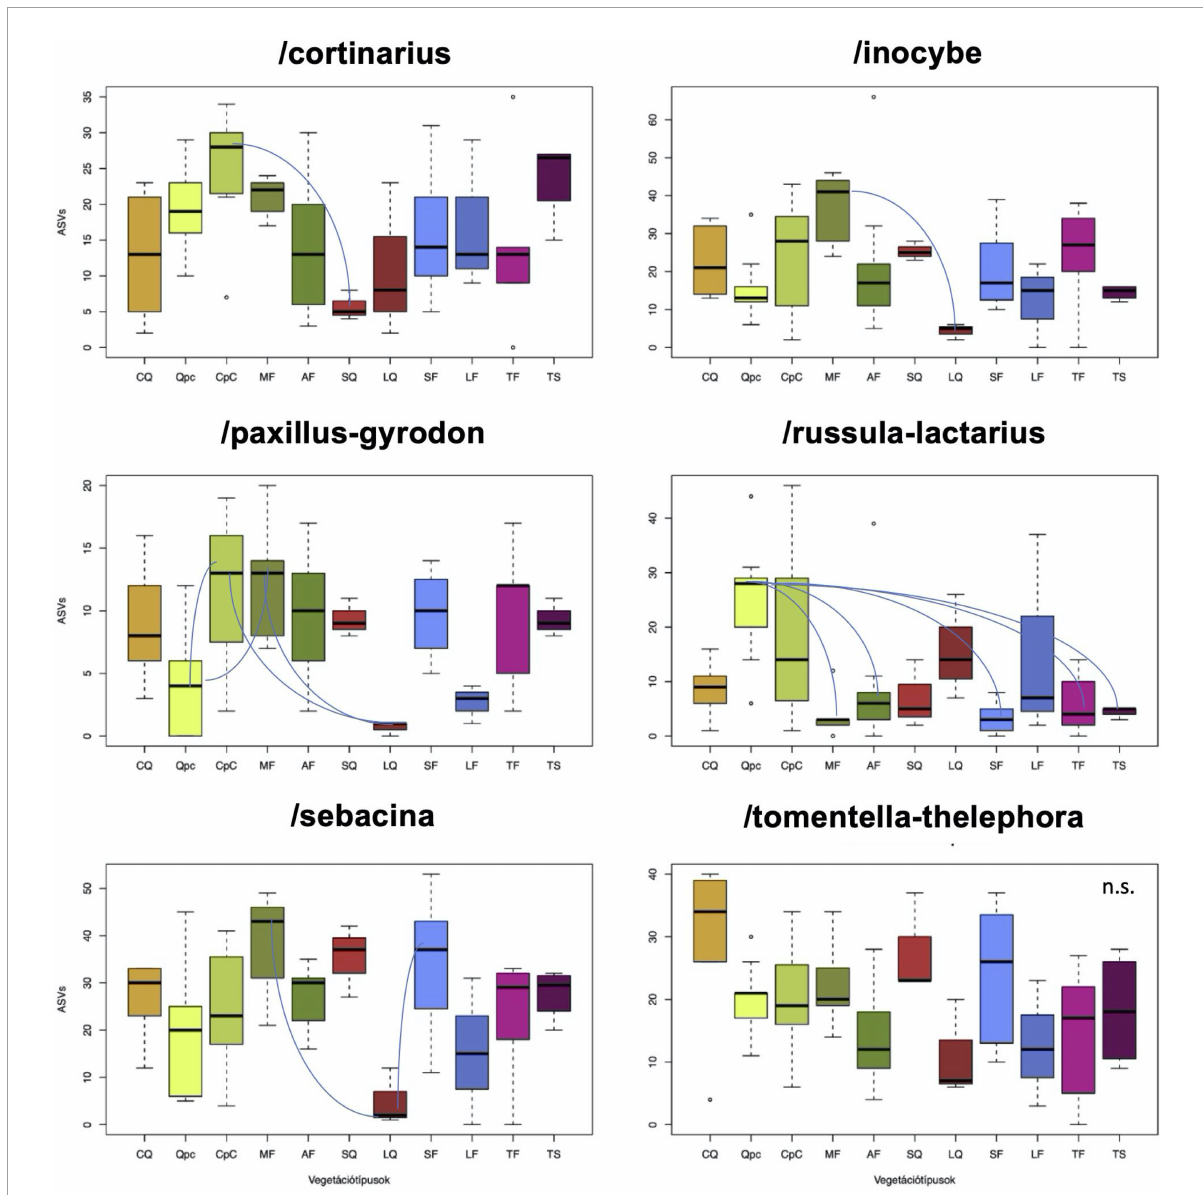
FIGURE2 Comparison of amplicon sequence variant (ASV) richness of the dominant ectomycorrhizal (ECM) fungal lineages across among the sampled forest types. Means were compared using ANOVA and Tukey’s HSD tests, with arches denoting significant differences. Forest types are described in detail in the text, with abbreviations provided in Table 1